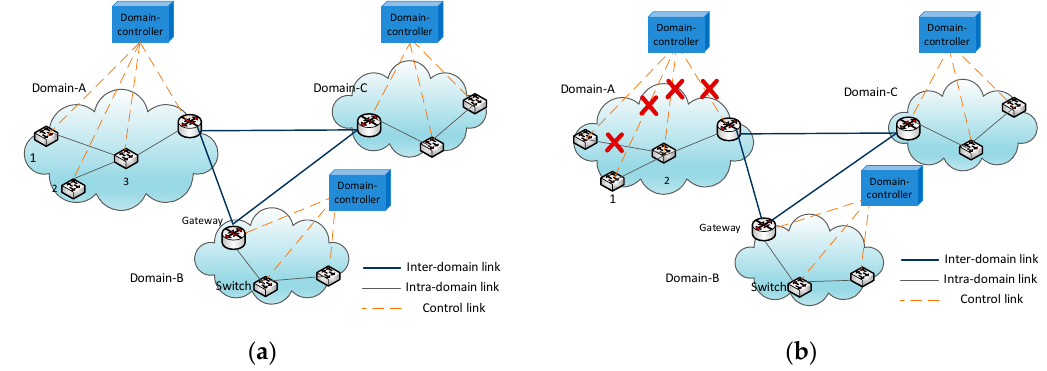
Figure 1. ( a ) Multi-domain software-defined wireless sensor networks (SDWSNs); ( b ) The link failure in a domain.